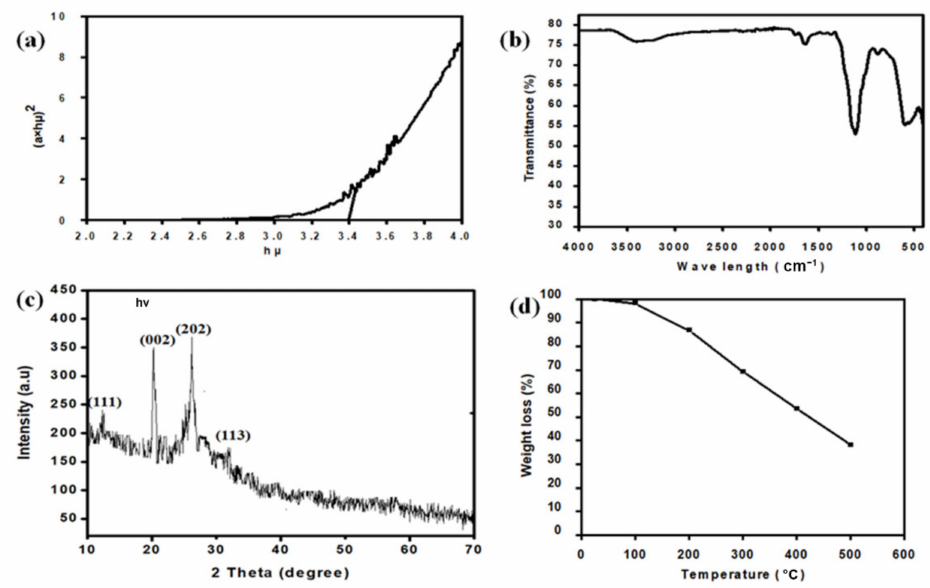
Figure 2. ( a ) Optical Band gap, ( b ) FTIR spectrum, ( c ) XRD representation and ( d ) TGA analysis of Biosynthesized